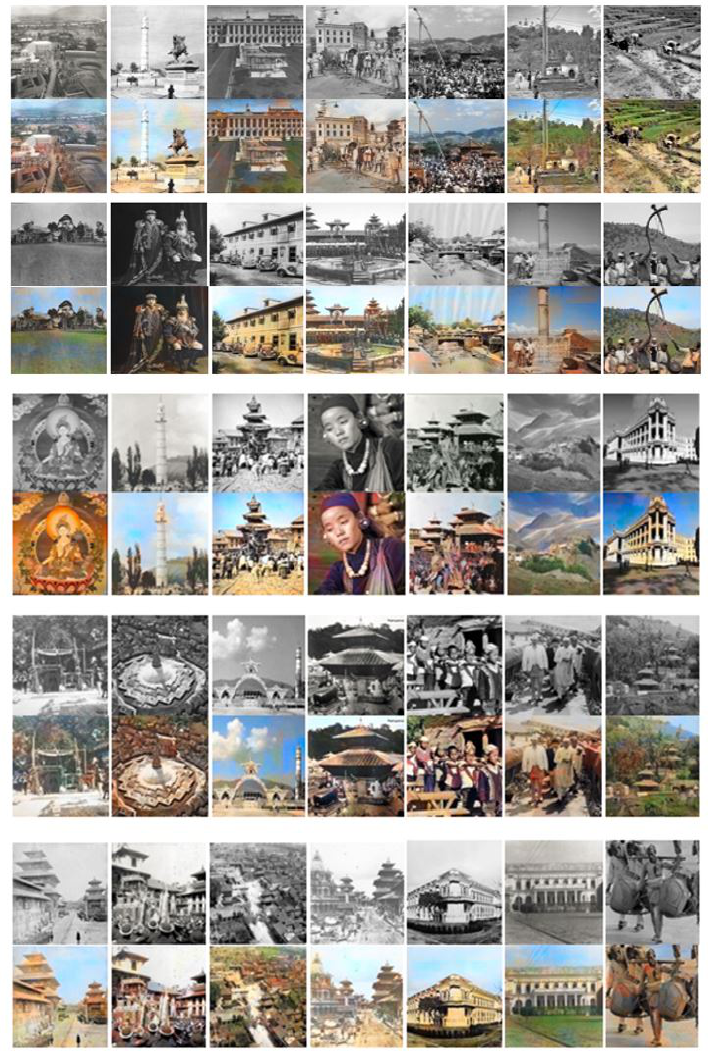
Figure 5. Results obtained on test images. Each odd row is input; each even row is corresponding output from the